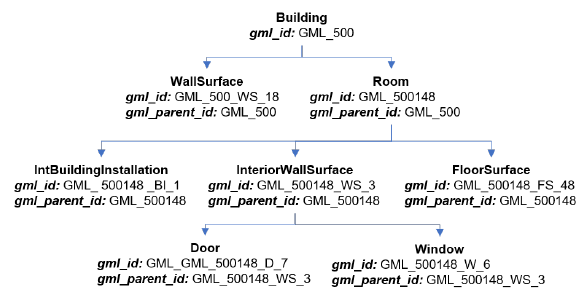
Figure 10. Agricultural Sciences Building’s Cafeteria: CityGML LOD4 hierarchy